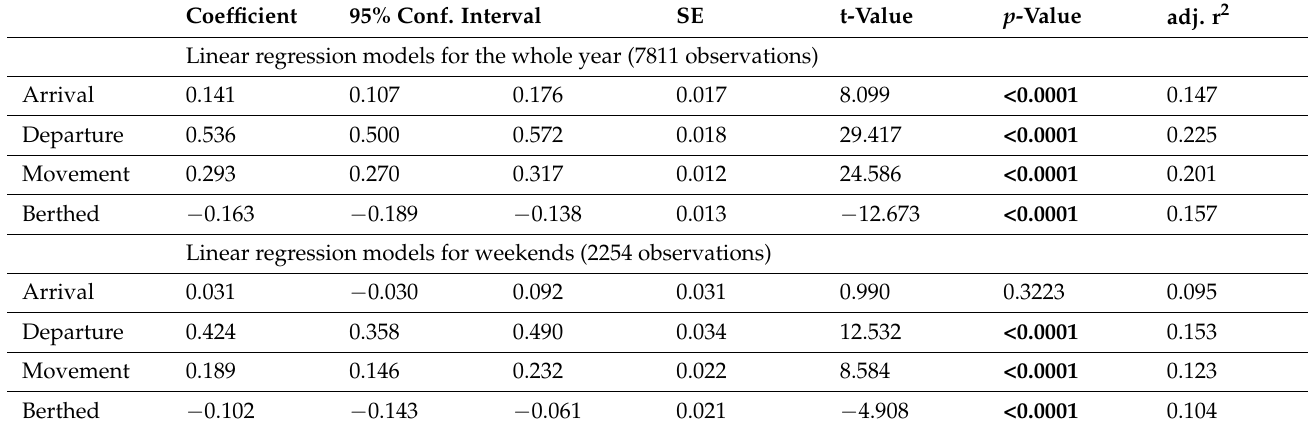
Table 10. Multivariable linear regression analysis results for vessel arrivals, departures, movement and laying alongside to the logarithm of NO 2 hourly mean concentrations controlled for wind direction, wind speed, relative humidity, air temperature and time of day at West Harbour in 2020. p -values less than 0.05 in bold.